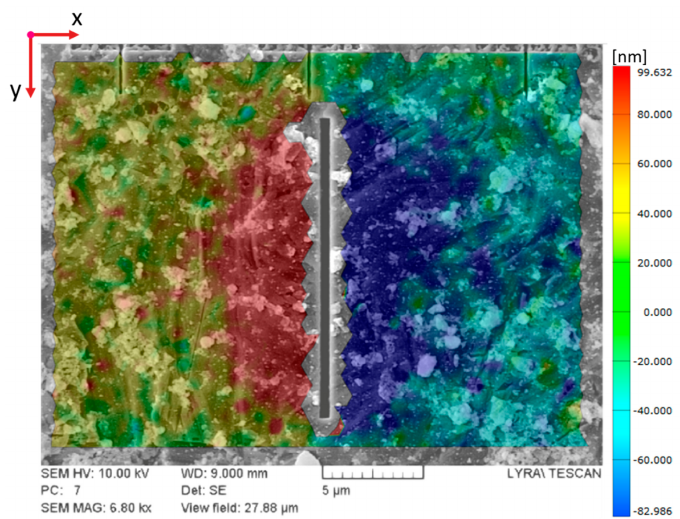
Figure 3. An arbitrary example illustrating the displacement field map from DIC analysis in GOM; image acquired over a field of view of ~28 µ m, the color bar in the right side shows the magnitude of recorded surface displacements due to stress relaxation by FIB milling along direction x on both sides of the slit. The values range between − 100 to +100